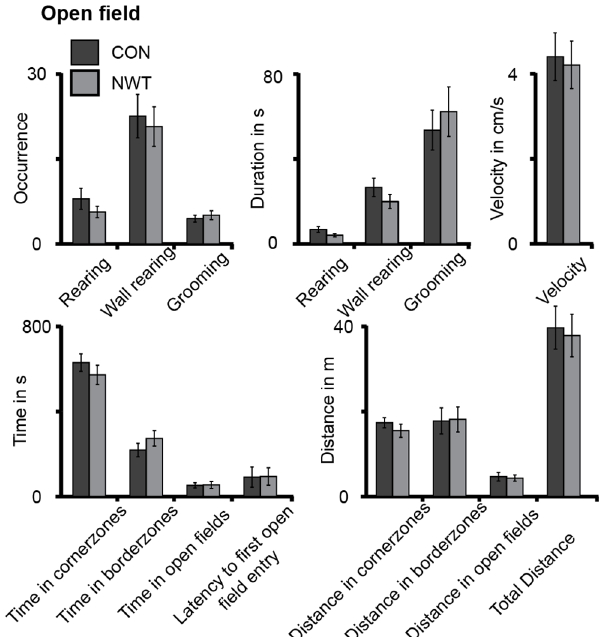
Fig 7. Exploratory and anxiety behavior of CON and NWT rats. Bar diagrams displaying the time spent and latency to enter as well as the distance travelled in each zone of the open field arena, the travel velocity, the mean frequency and duration of rearing, wall rearing, and grooming events averaged for 15 CON (black) and 18 NWT rats (gray). The underlying data of this figure can be found in S1 Data. http://dx.doi.org/10.6084/